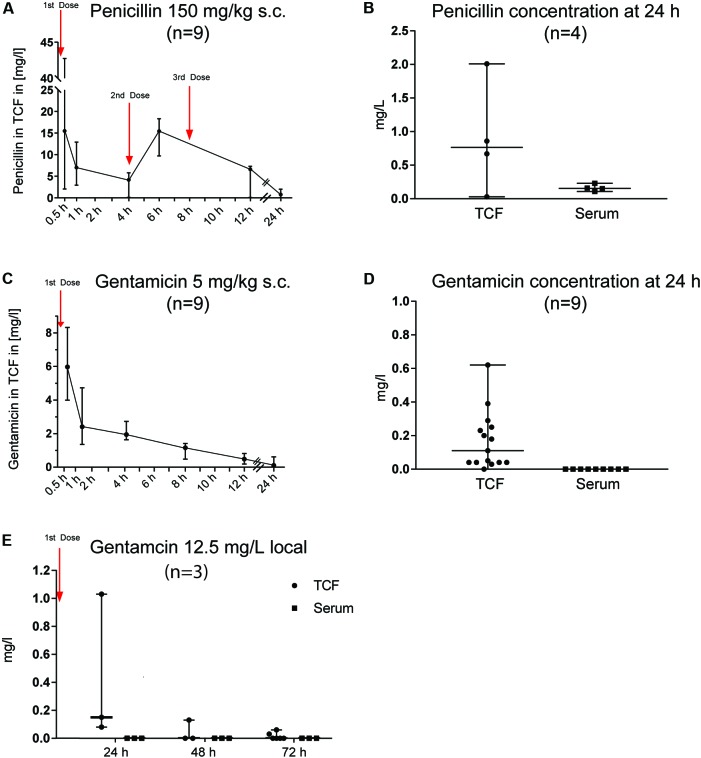
Pharmacokinetics of penicillin G (PEN) and gentamicin (GEN) in tissue cage fluid (TCF) and serum. The numbers in brackets reflect the total number of animals used for the PK study. At each measured time point, three samples from three different animals were obtained. The time interval in obtaining two consecutive TCF samples was never <6 h in any animals (to minimize their stress). Results are presented as median ± range. (A) PEN 150 mg/kg body weight (BW) subcutaneously (s.c.) given three times (every 4 h). (B) PEN 150 mg/kg BW s.c. given three times (every 4 h) and measured in TCF and serum after 24 h. (C) GEN 5 mg/kg BW s.c. given once daily. (D) GEN 5 mg/kg BW s.c. given once daily and measured in TCF and serum after 24 h. (E) GEN 12.5 mg/L applied locally once and the concentration measured in TCF and serum after 24, 48, and 72 h.